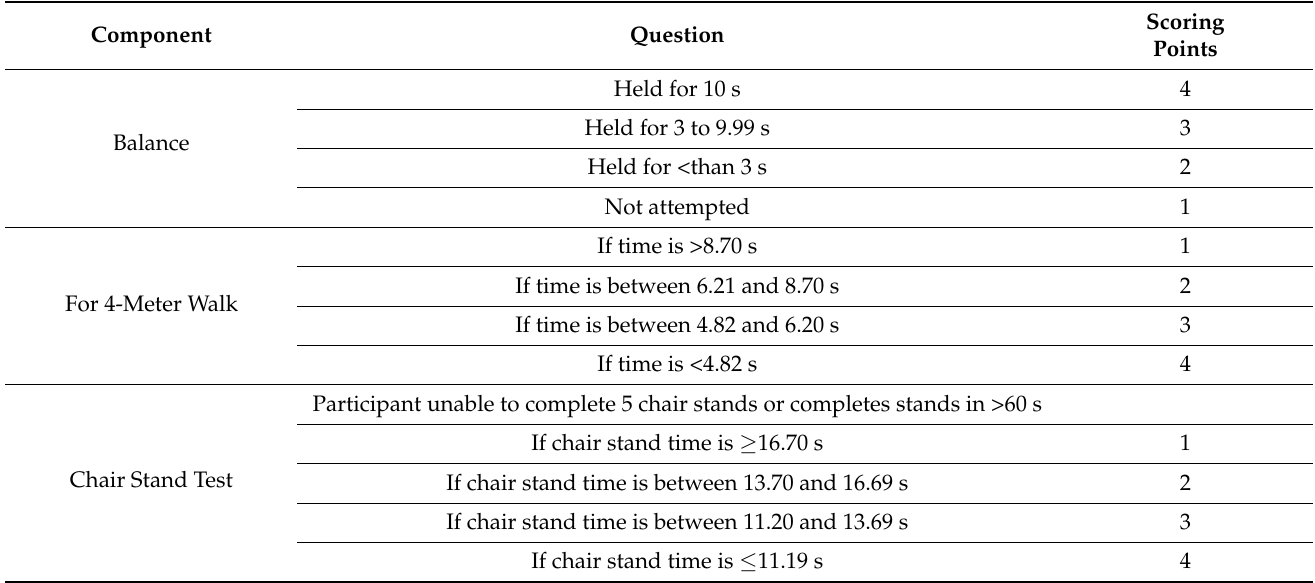
Table 2. Short physical performance battery protocol and score sheet (SPPB)